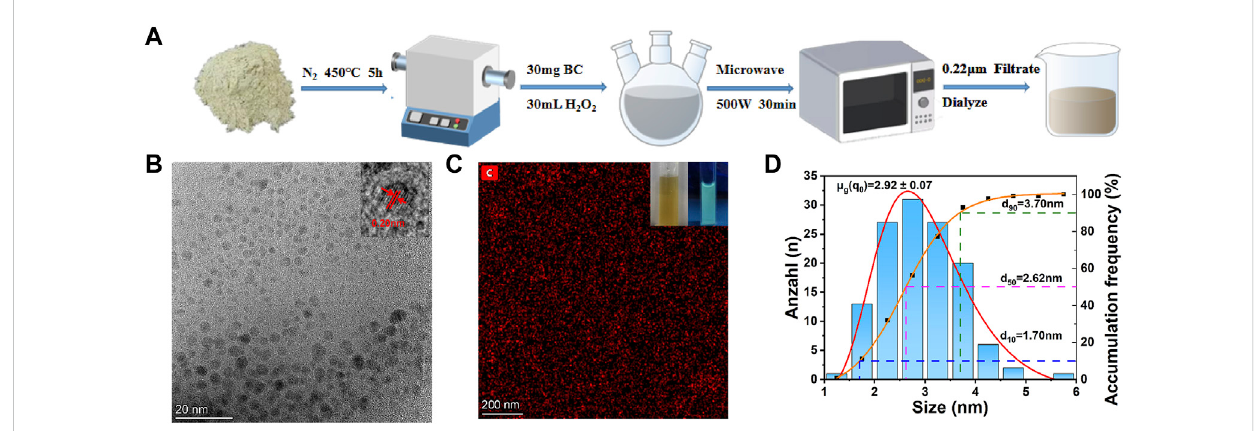
FIGURE 1 (A) The synthetic scheme of CDs from CSP. (B) TEM images of CDs. Inset is the high-resolution TEM image. (C) EDX mapping images of CDs. Insets are the photographs of the obtained CDs solution illuminated under sunlight and a UV lamp (365 nm), respectively. (D) Particle size distribution of